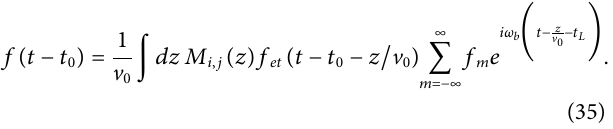
Frontiers in Physics |